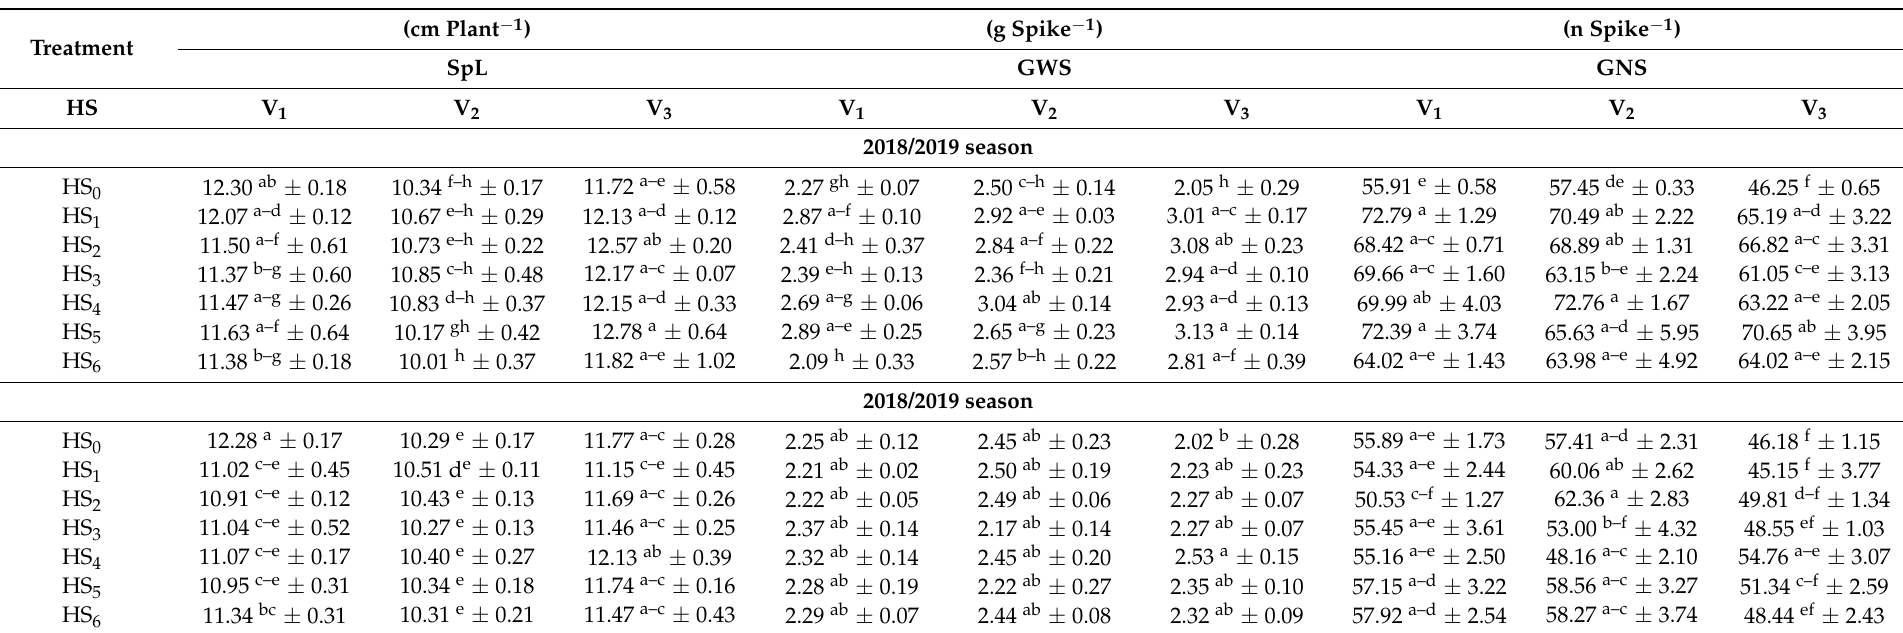
Table 6. Influence of the interaction between humic substances and varieties on spike length, grain weight and grain number per spike of wheat plants grown in clay loam soil in 2018/2019 and 2019/2020